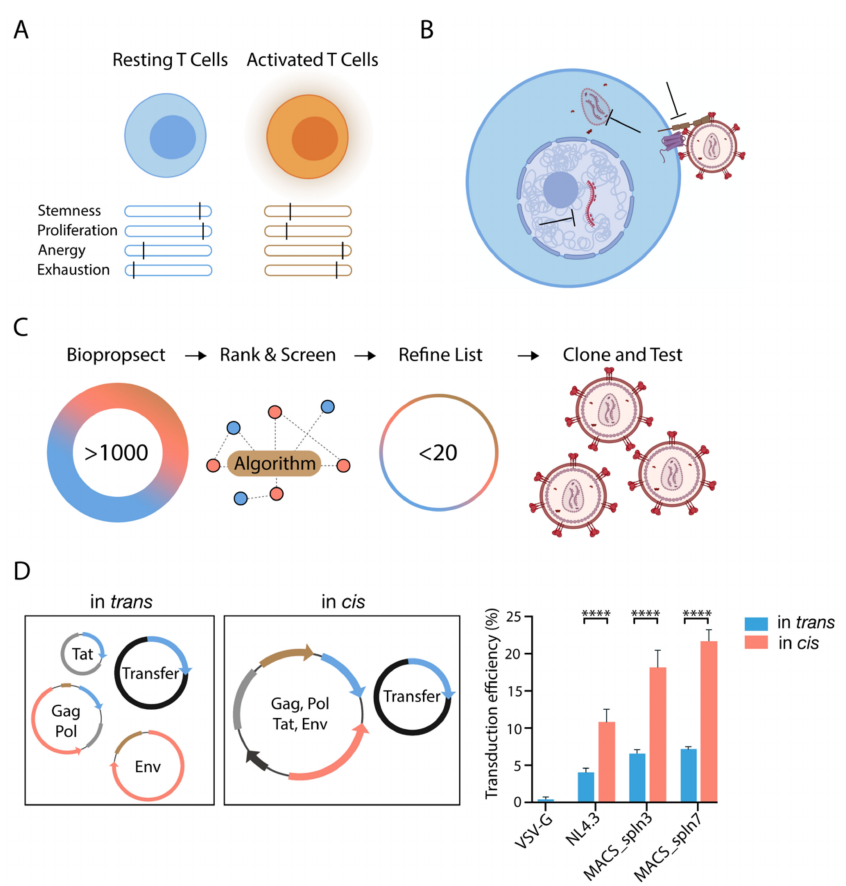
Figure 1. Creation of a lentiviral vector pseudotype discovery pipeline to overcome lentiviral restric- tion at the plasma membrane imposed by resting CD4 + T cells. ( A ) Activation results in T cells that have considerably reduced proliferative potential post-infusion, and increased anergic/exhaustive states that limits effector function. ( B ) Lentiviral vectors are identified to be restricted in resting CD4 + T cells at three levels: Firstly, at the membrane through limiting vector entry, secondly within the cytoplasm through limiting reverse transcription and sensing of nascent transcripts, and thirdly within the nucleus by limiting integration. ( C ) A selective pseudotype identification strategy was implemented to determine a pseudotype with the highest fusogenic potential in resting CD4 + T cells. Pseudotypes were initially ranked algorithmically, then the highest ranked pseudotypes were tested experimentally for their fusion potential, resulting in the selection of a limited pool of highly fuso- genic pseudotypes for further utilization. ( D ) Representation of in cis and in trans vector production methods. In cis expression results in a significant increase in end-point transduction compared to in trans expression, tested orthogonally in three pseudotyping approaches. VSV-G pseudotyped lentiviral vectors were included as negative control. Averages of three patients, with reactions performed in duplicate, are shown. Statistical tests were Student’s t test against matched in trans controls. **** p <